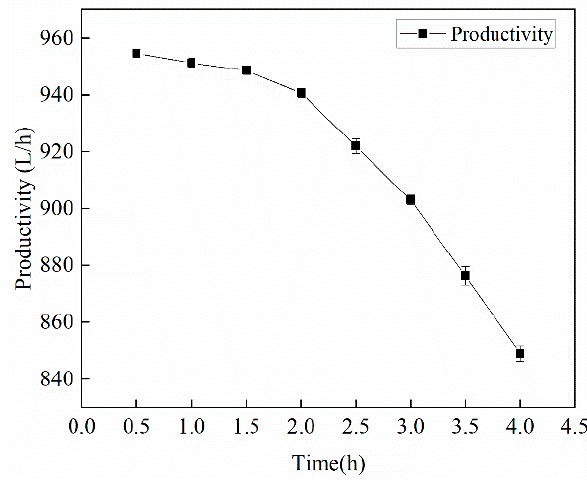
Figure 3. Treatment efficiency changes over time.